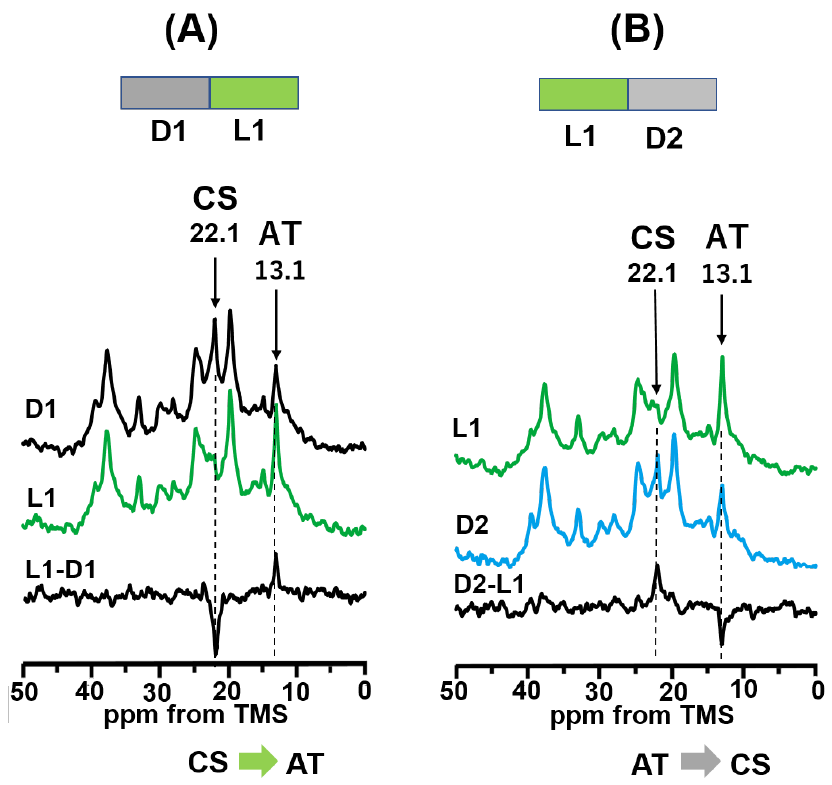
Figure 2. ( A ) Photo reaction pathway of [20- 13 C]retinal-WT-BR under green light (520 nm) illumina- tion at 20 °C. 13 C CP-MAS NMR spectra were recorded in the dark (D1; 20- 13 C) and under green light (L1; 20- 13 C), and the difference in spectra between L1 and D1 (L1-D1; 20- 13 C) indicated that the CS state changed to the AT state. ( B ) Photoreaction pathway in the dark after green light illumina- tion at 20 °C. 13 C CP-MAS spectra were recorded under green light (L1; 20- 13 C) and in the dark one day after L1 (D2; 20- 13 C), and the difference in spectra between D2 and L1 (D2-L1; 20- 13 C) indicated that the AT state changed to the CS state. Table 1. 13 C and 15 N chemical shift values (ppm) of individual states of [20- 13 C, 14- 13 C]-retinal and [ ε - 15 N]Lys-bacteriorhodopsin(WT-BR) and D96N-BR.